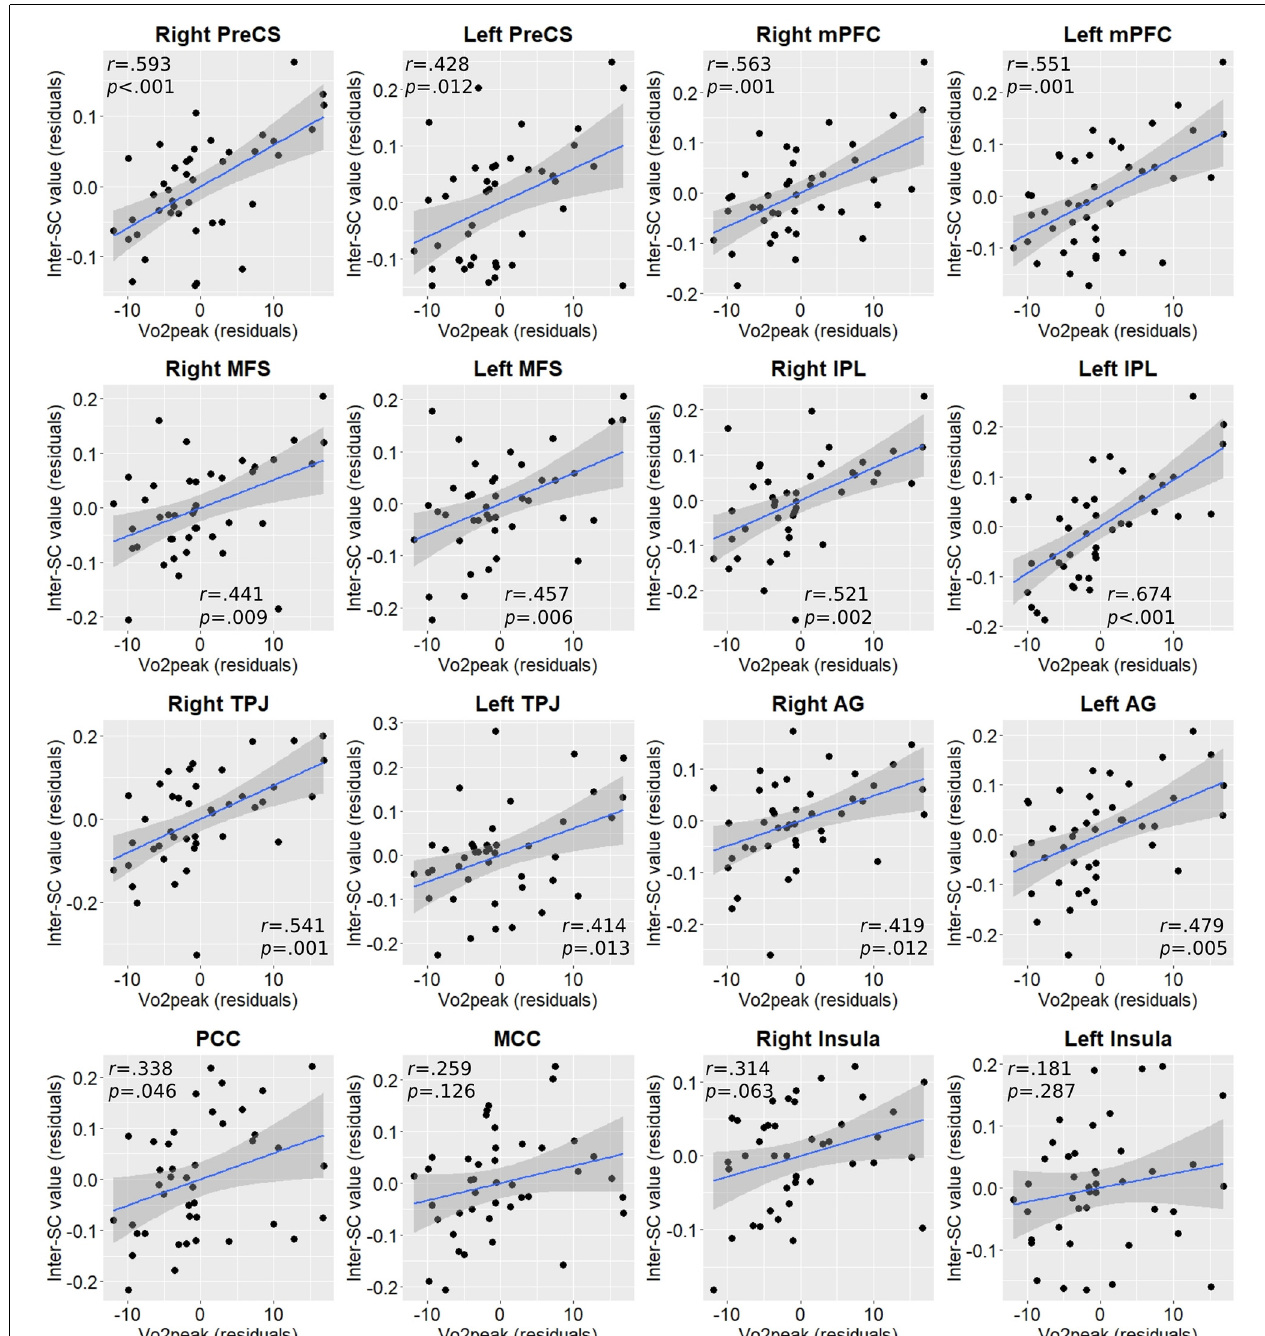
FIGURE 3 | Partial correlation plots between Vo 2 peak and inter-SC values in regions exhibiting between-group differences. P-values are FDR-corrected for multiple comparisons. AG, angular gyrus; IPL, inferior parietal lobule; MCC, middle cingulate cortex; MFS, middle frontal sulcus; mPFC, medial prefrontal cortex; PCC, posterior cingulate cortex; PreCS, precentral sulcus; TPJ, temporoparietal